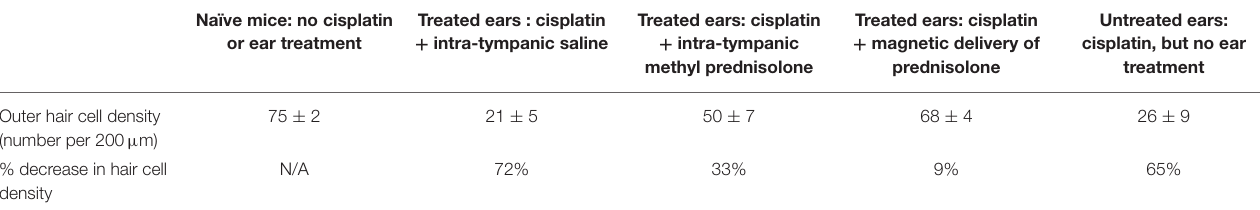
TABLE 2 | Comparison of outer hair cell density for cochleas in naïve mice ( N = 6), vs. in mice that received the three ear treatment types (also N = 6 for each group). The second row lists the percent decrease in hair cell density compared to the no cisplatin naïve group. In the magnetically treated group D, hair cell density decreased by just 9% compared to substantially greater hair loss in the other